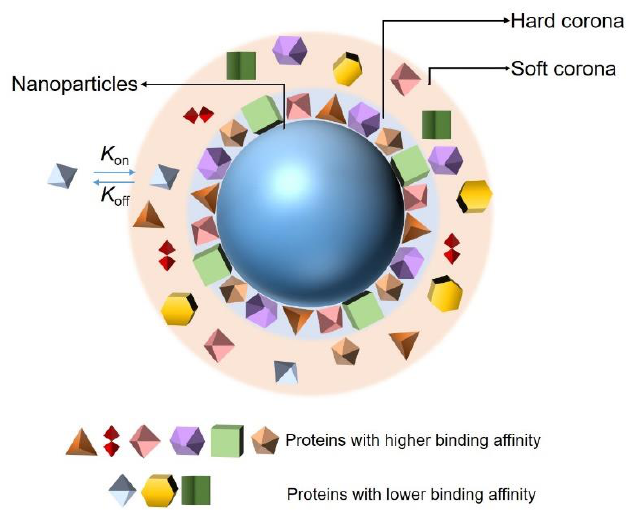
Figure 1. Schematic representation of the current protein corona hypothesis.